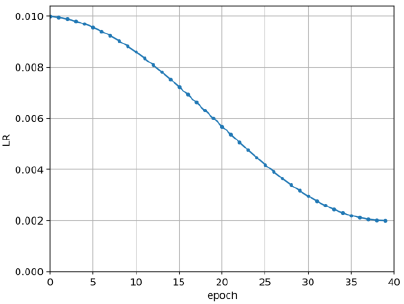
Figure 8. The plot created by the cosine annealing learning rate scheduler, starting from a value of 10 −2 and decaying to a final value of 2 × 10 −3 over the course of 40 epochs.